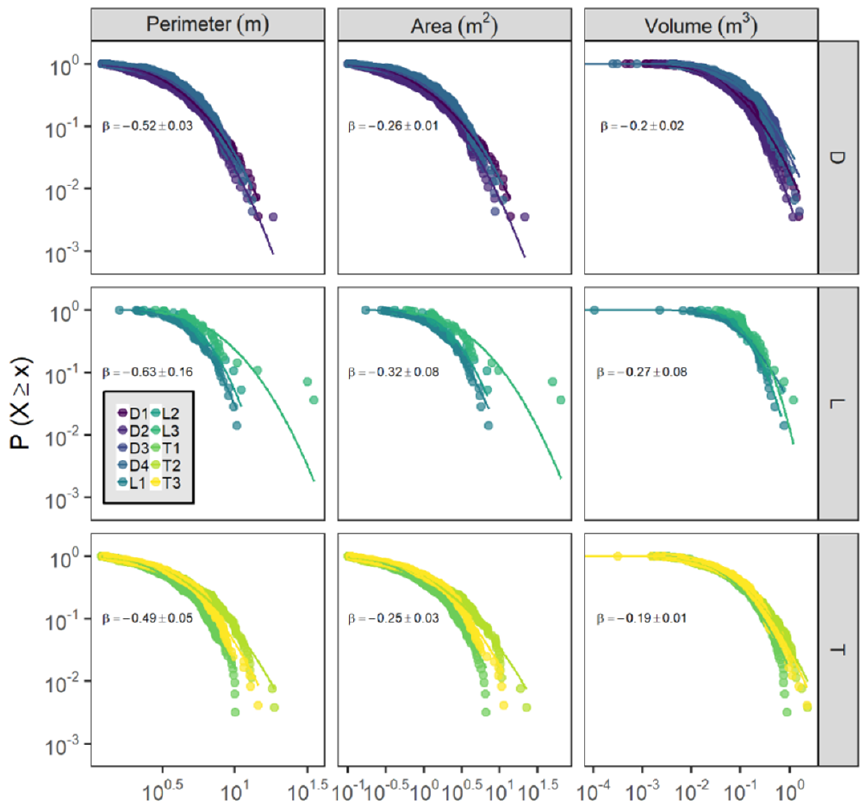
Figure 9. Inverse cumulative distributions of hummock dimensions (perimeter, area, and volume) across sites (points), split by hummock dimension and site type. The y axis is the probability that a hummock dimension value is greater than or equal to the corresponding value on the x axis. The best-fit lognormal distributions are shown for each site as lines. All fits were highly significant ( p (cid:28) 0 . 001). The text indicates the mean ( ± SD) within-group coefficient for a model of the form P(X ≥ x) = β · ln ( dimension_value ) + β 0 .